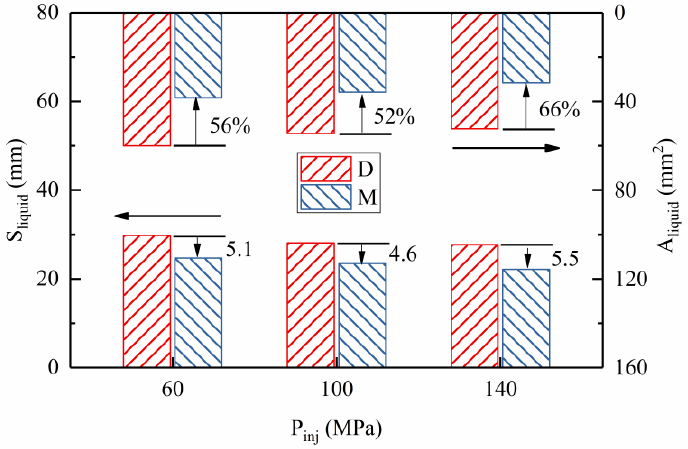
Figure 6. Quantitative results of the liquid phase spray under different injection pressure condi- tions.